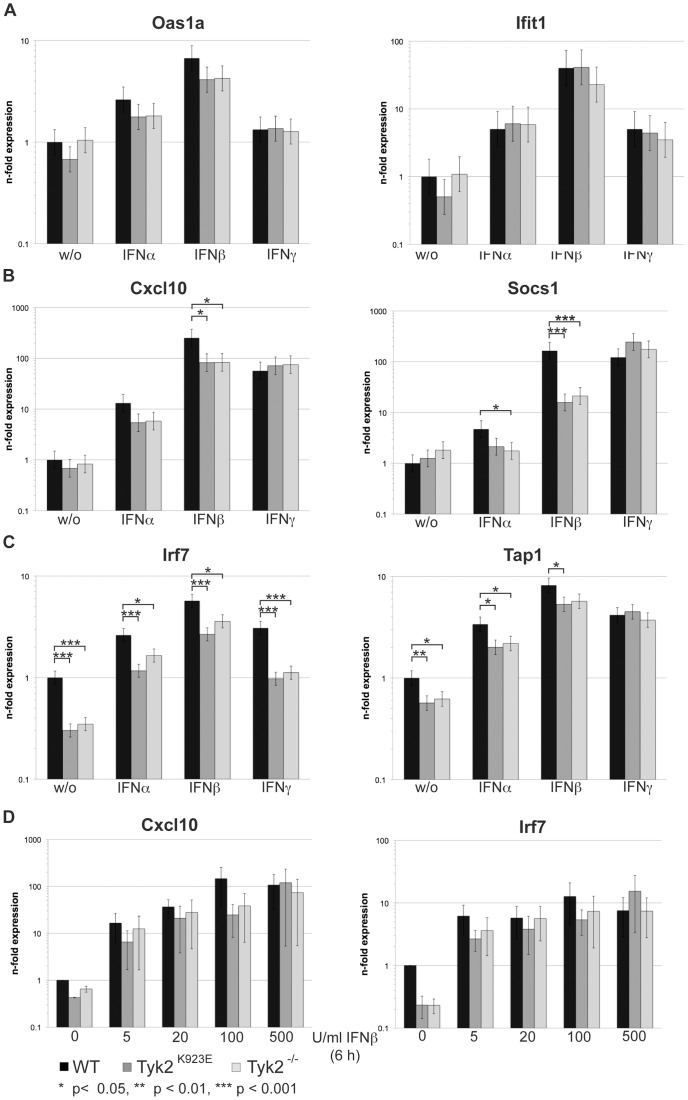
Transcriptional induction of IFN-responsive genes is similar in Tyk2K923E and Tyk2−/− cells.A.-C. WT, Tyk2−/− and Tyk2K923E BMMΦs were treated with IFNα (500 U/ml), IFNβ (100 U/ml) or IFNγ (100 U/ml) for 6 h or left untreated. Total RNA was extracted, reverse-transcribed and analysed by RT-qPCR for expression of Oas1a, Ifit1 (A), Cxcl1, Socs1 (B) and Irf7, Tap1 (C). Ube2D2 was used for normalization and expression levels were calculated relative to untreated WT cells. Data are derived from three independent experiments and depicted as mean values (+/− SE). D. WT, Tyk2−/− and Tyk2K923E BMMΦs were treated with indicated doses of IFNβ for 6 h. Target gene expression was determined as described in A-C. Mean values (+/− SD) derived from two independent experiments are depicted. Note that due to sample size a statistical analysis was not performed.